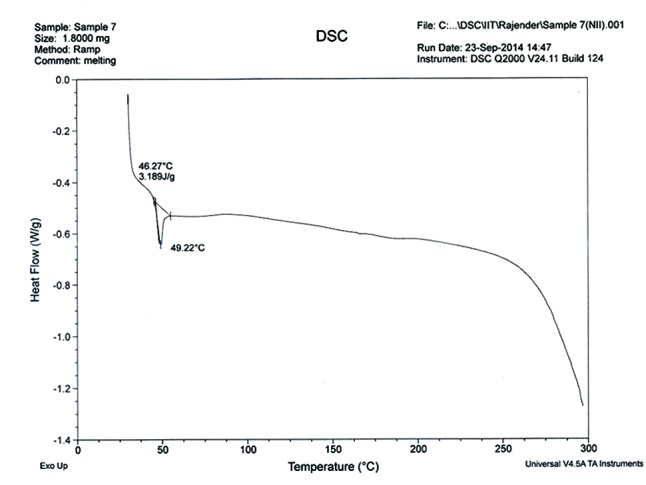
Thermograms of Cur-PLGA entrapped nanoparticles.